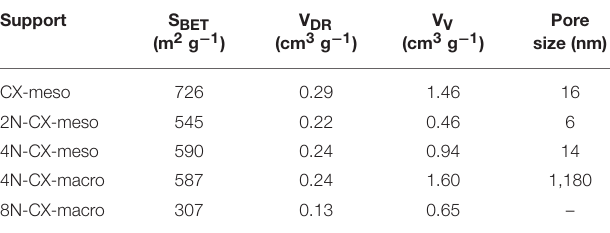
TABLE 4 | Porous texture properties for N -doped carbon xerogels